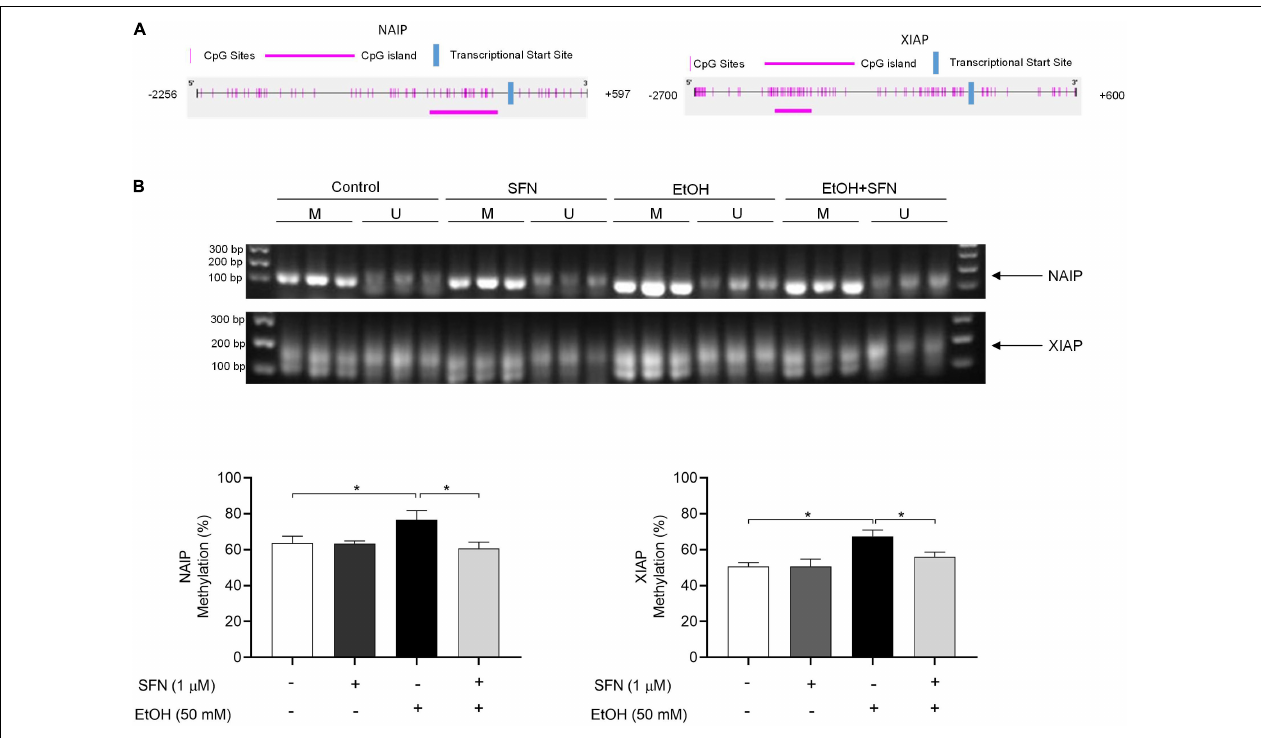
FIGURE 3 | SFN significantly diminished the ethanol-induced hypermethylation at the promoters of XIAP and NAIP in hNCCs. hNCCs were treated with 1 µ M SFN for 24 h, followed by concurrent exposure to 1 µ M SFN and 50 mM ethanol for an additional 24 h. (A) Schematic illustration of the CpG sites and CpG island in the promoters of NAIP and XIAP. The selected CpG island in the NAIP gene promoter is in the region from –634 to –64 bp in the promoter of NAIP. The selected CpG island in the XIAP gene promoter is in the region from –2156 to –1734 bp in the promoter of XIAP. (B) DNA methylation status at the CpG island of the promoters of NAIP and XIAP was determined by using MSP. Data are expressed as the percentage of methylation and represent the mean ± SEM of three separated experiments. * p < 0.05. M, methylated DNA, U, unmethylated DNA.